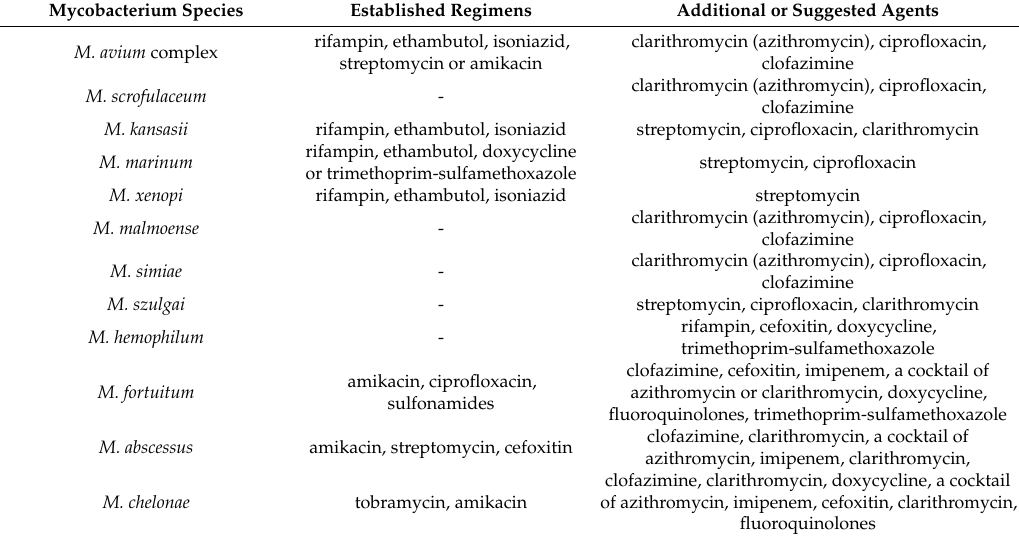
Table 2. Various treatment recommendations for NTM